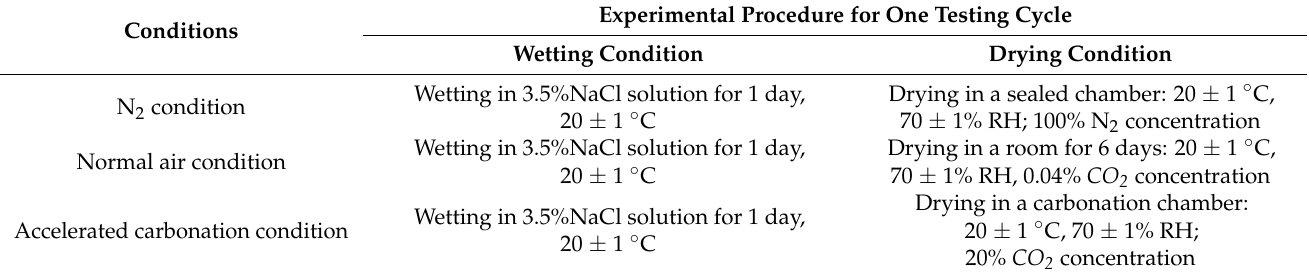
Table 2. The detailed information of the three exposure